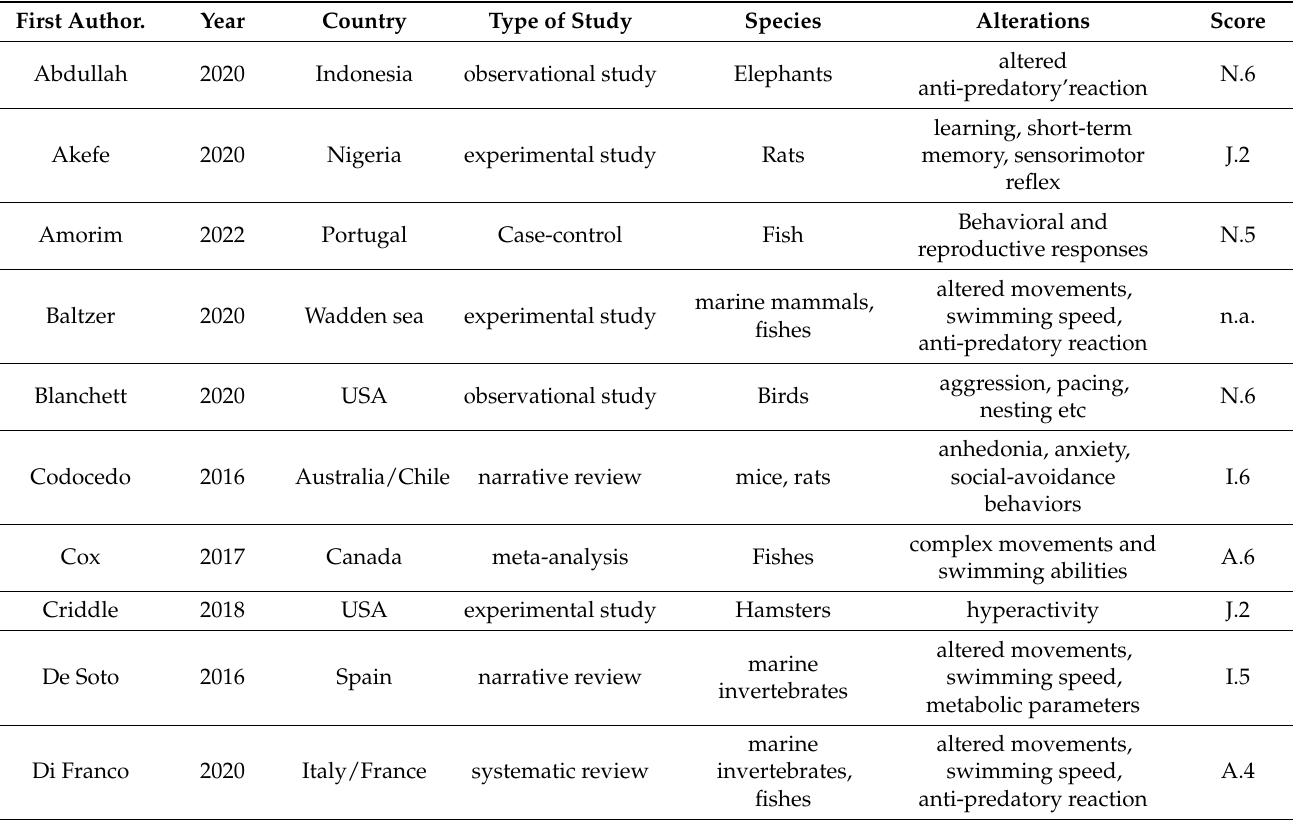
Table 2. Included studies in this systematic review, in alphabetical order, with their relative